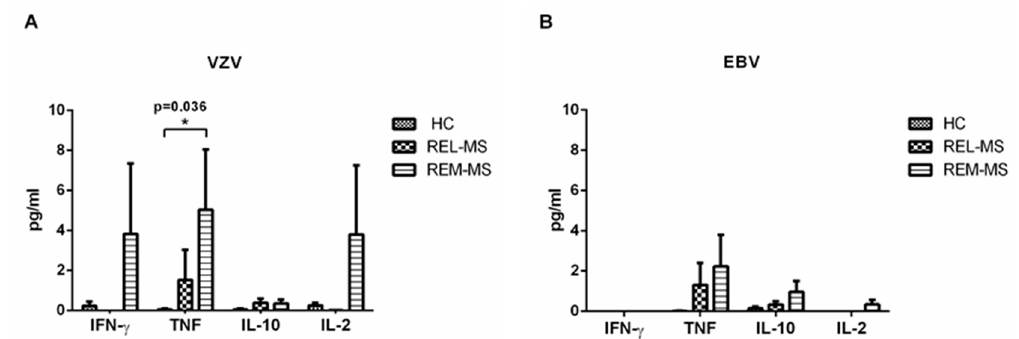
Figure 4. Cytokines secreted in PBMC cultures stimulated with VZV or EBV. A predominance of IFN- γ , TNF and IL-2 was observed in cell cultures of REM-MS patients stimulated with VZV ( A ). Low concentration of cytokines was obtained in cultures stimulated with EBV ( B ). * p <